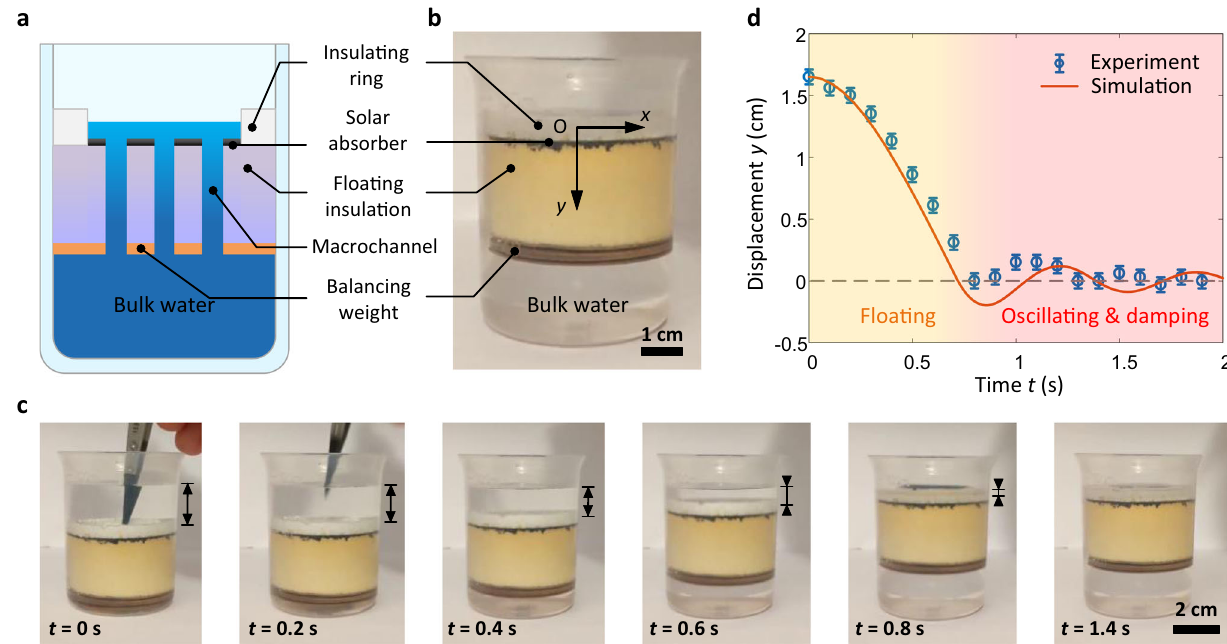
Fig. 2 Prototype of the con fi ned water layer structure. Schematic ( a ) and image ( b ) of the fabricated prototype comprising of an insulating ring, a solar absorber, a fl oating insulation, fi ve macrochannels, and a balancing weight. c Time-lapse images showing the dynamic response of the con fi ned water layer structure under extreme displacement. d Con fi ned water layer displacement y as a function of time t extracted from time-lapse images (blue data points) and simulated by a buoyancy-driven damped oscillator model (red curve). The thermal insulation layer experienced a rapid fl oating process (yellow regime) followed by a weak oscillating and damping process (light red regime). Error bars were determined by the spatial and temporal resolution of time-lapse